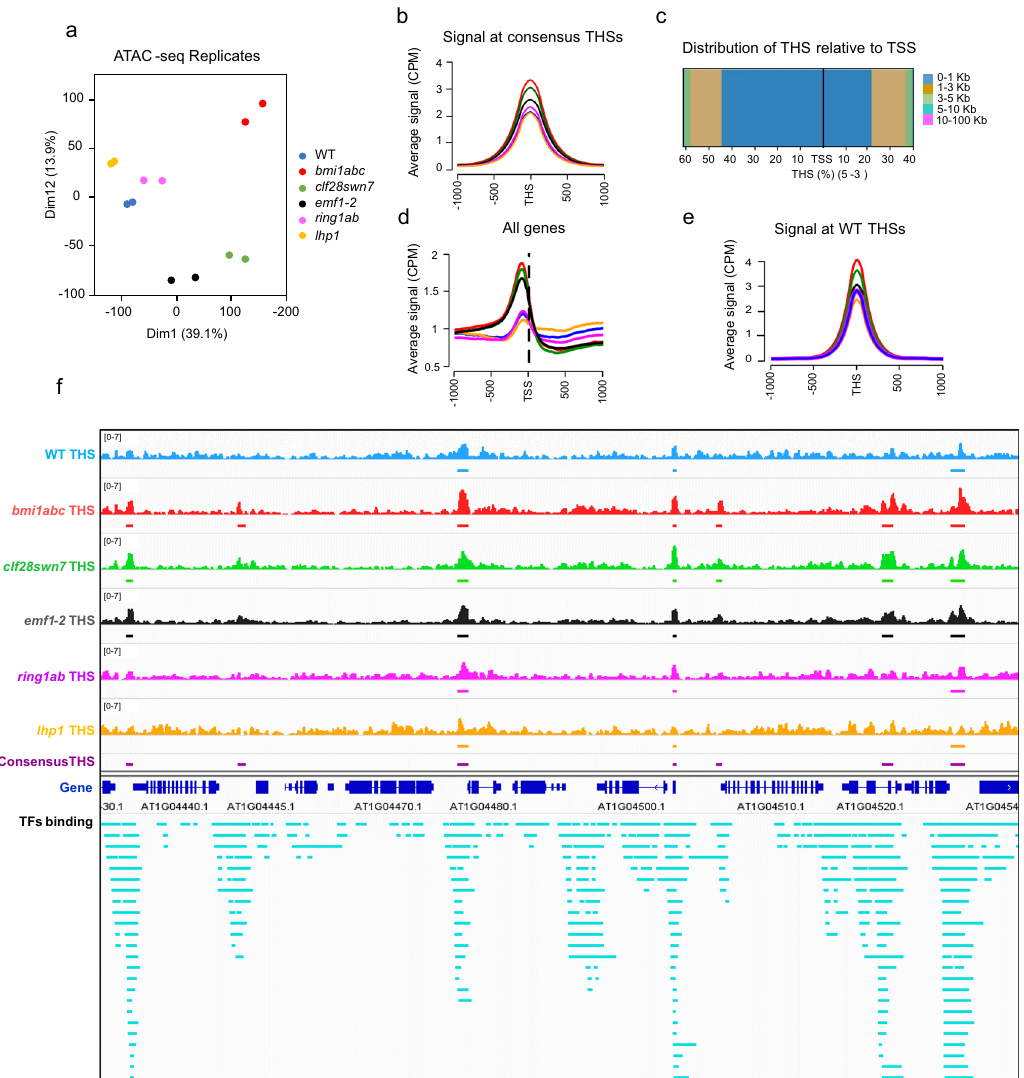
Fig. 1 Consensus THSs co-localize with transcriptional regulation hotspots. a PCA analysis of WT, bmi1abc , clf28swn7 , emf1-2 , lhp1 , and ring1ab ATAC-seq replicates at 10 DAG. b Average signal levels at the center of consensus THSs in WT, bmi1abc , clf28swn7 , emf1-2 , lhp1 , and ring1ab mutants. c Distribution of consensus THSs relative to TSS. The percentage of THSs found in different intervals is indicated in different colors. d Average accessibility pro fi le of coding genes at the region surrounding the TSS in WT and mutants. e Average signal levels at the center of WT THSs in WT, bmi1abc , clf28swn7 , emf1-2 , lhp1 , and ring1ab mutants. f Screenshot showing distribution of genotype-speci fi c THSs, consensus THSs, and TFs binding sites (see also Supplementary Data 2). Each genotype is indicated in different color (WT in blue, bmi1abc in red, clf28swn7 in green, emf1-2 in black, ring1ab in pink, and lhp1 in orange). Consensus THSs are indicated in magenta. Gene regions are indicated in dark blue and the binding sites of TFs in greenish